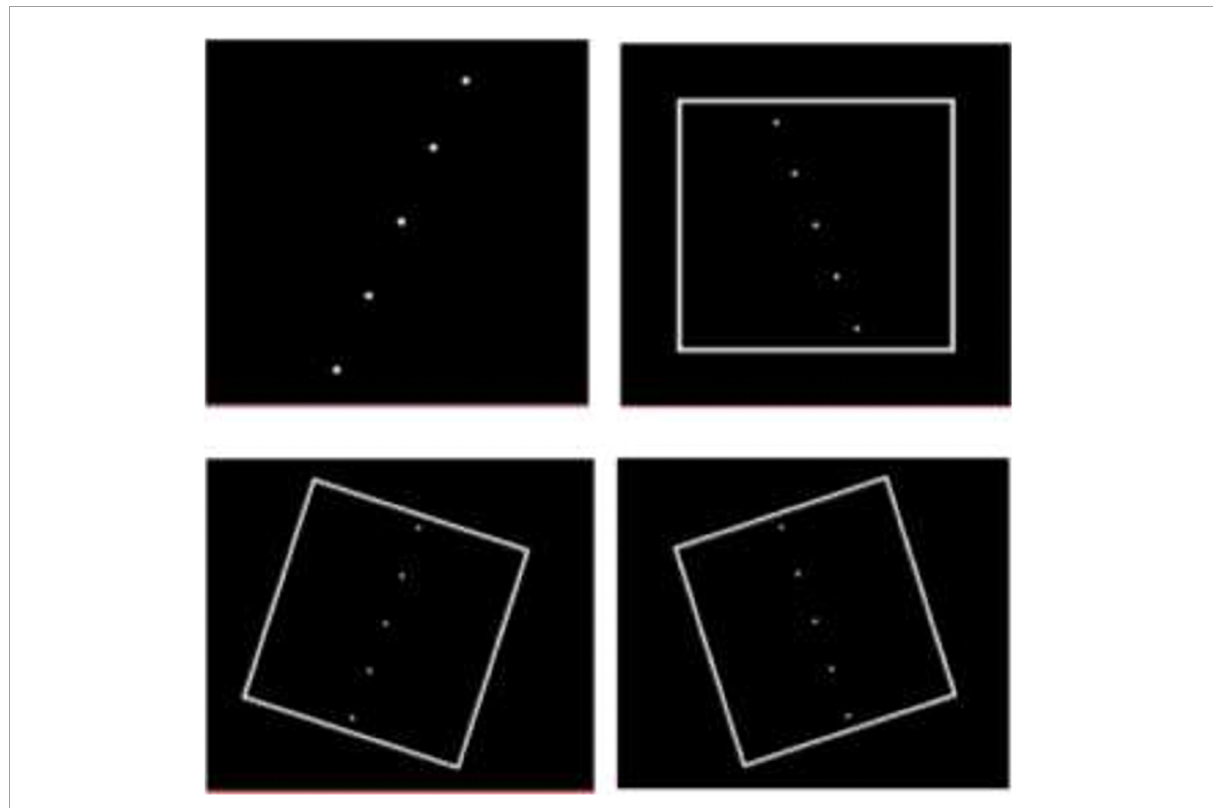
FIGURE2 Presentations of “rod and frame” during testing. Some presentations were with no surrounding frame. For frame context, the frame was displayed in a randomized order as either erect or tilted by 18 ◦ clockwise or counter clockwise.